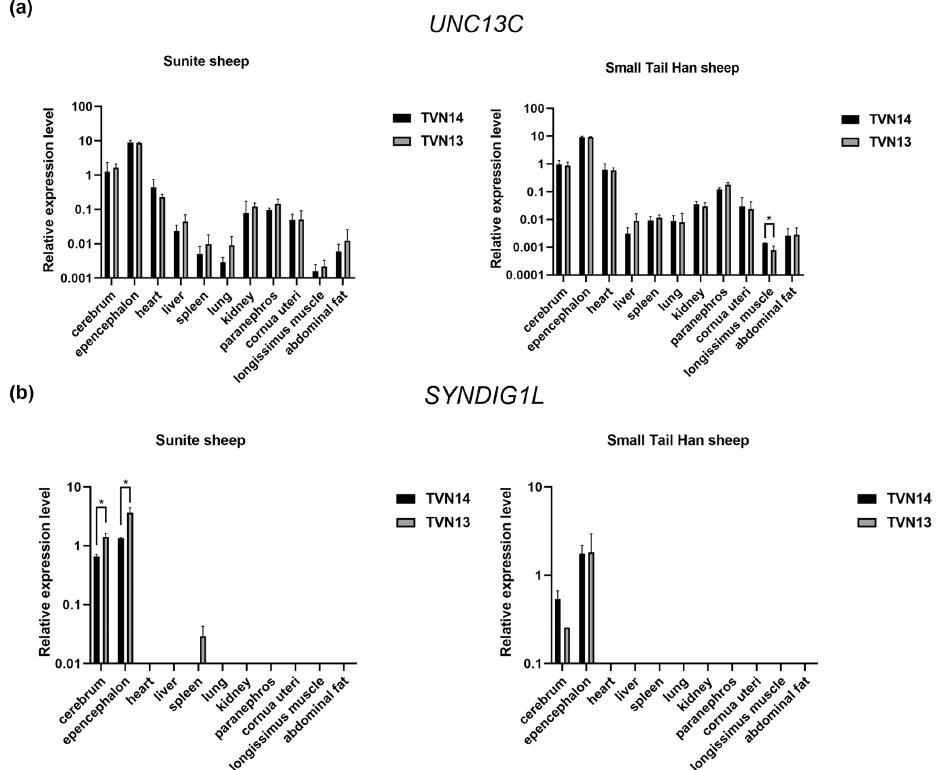
Figure 2. Results of expression level of UNC13C and SYNDIG1L genes in STH and SNT with different TVNs. (a) The comparison of expression levels of UNC3C between SNT and STH. (b) The comparison of expression levels of SYNDIG1L between SNT and STH. The significant results with a p value lower than 0.05 are given one asterisk ( ∗